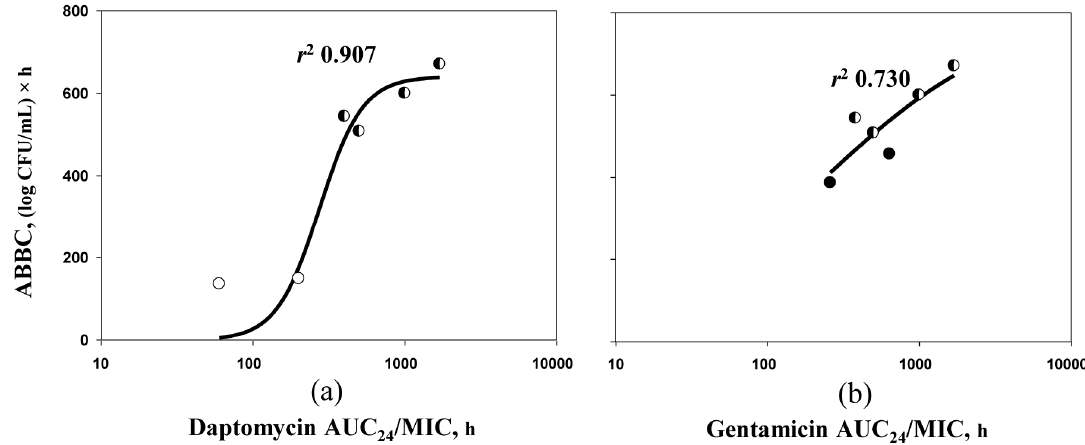
Figure 3. AUC 24 / MIC-related areas between the control growth curve and each time–kill curve (ABBCs) observed with S. aureus 293 in single treatments with daptomycin (open circles) or gentamicin (filled circles) and in combined treatments (half-filled circles). The relationships fit by Equation (1): ( a ) Y 0 = 0, x 0 = 2.438, a = 640.7, b = 0.1409 and ( b ) Y 0 = 0, x 0 = 2.385, a = 804.0, b = 0.5956.